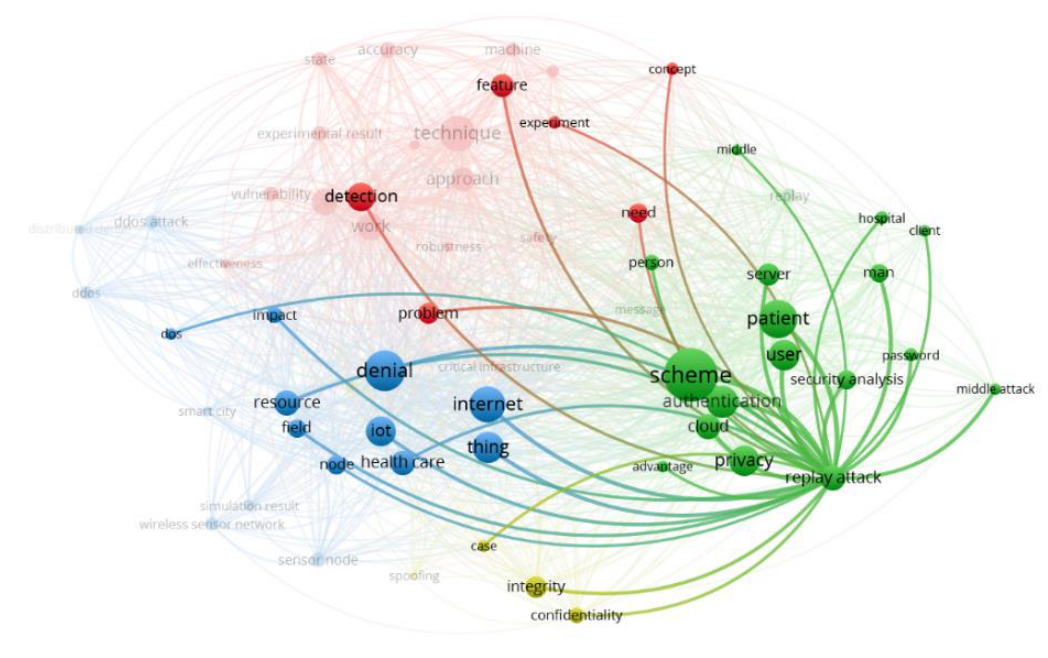
Figure 6. Relevance and occurrence study — binary counting.